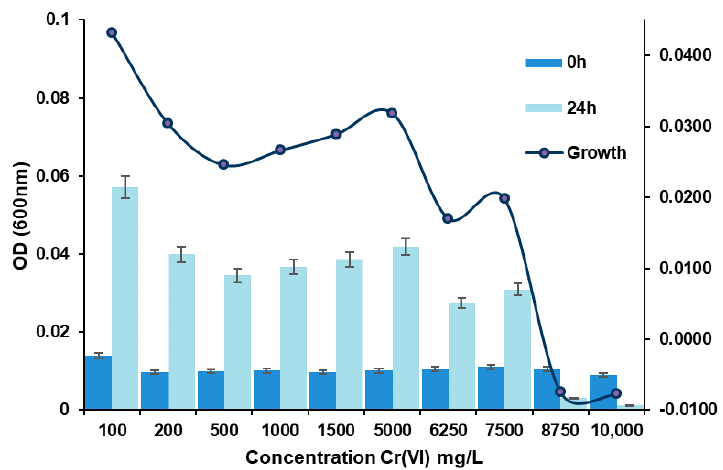
Figure 1. Growth of strain NA2. The cells were cultured on Luria–Bertani broth supplemented with 100, 200, 500, 1000, 1500, 5000, 6250, 7500, 8750 and 10,000 mg/L Cr(VI), respectively. The optical density was measured after incubation for 24 h at 37 °C.